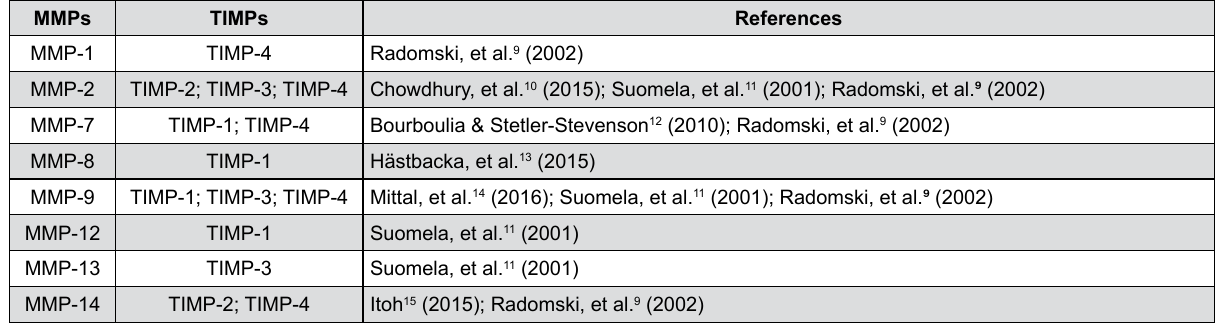
Figure 1- List of major MMPs involved in bone repair processes and their tissue inhibitors (TIMP) 9-15